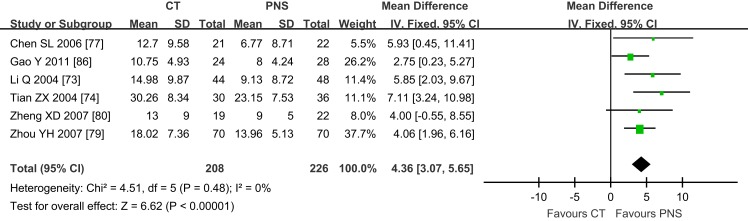
Meta-analyses of the neurological deficit score (NDS). The overall effect showed significant statistical difference in NDS between the PNS and CT groups (MD = 4.36; 95% CI = 3.07, 5.65; P < 0.00001). No heterogeneity (P = 0.48) was found in NDS (6 trials). PNS, Panax notoginseng saponin; CT, Current treatment.